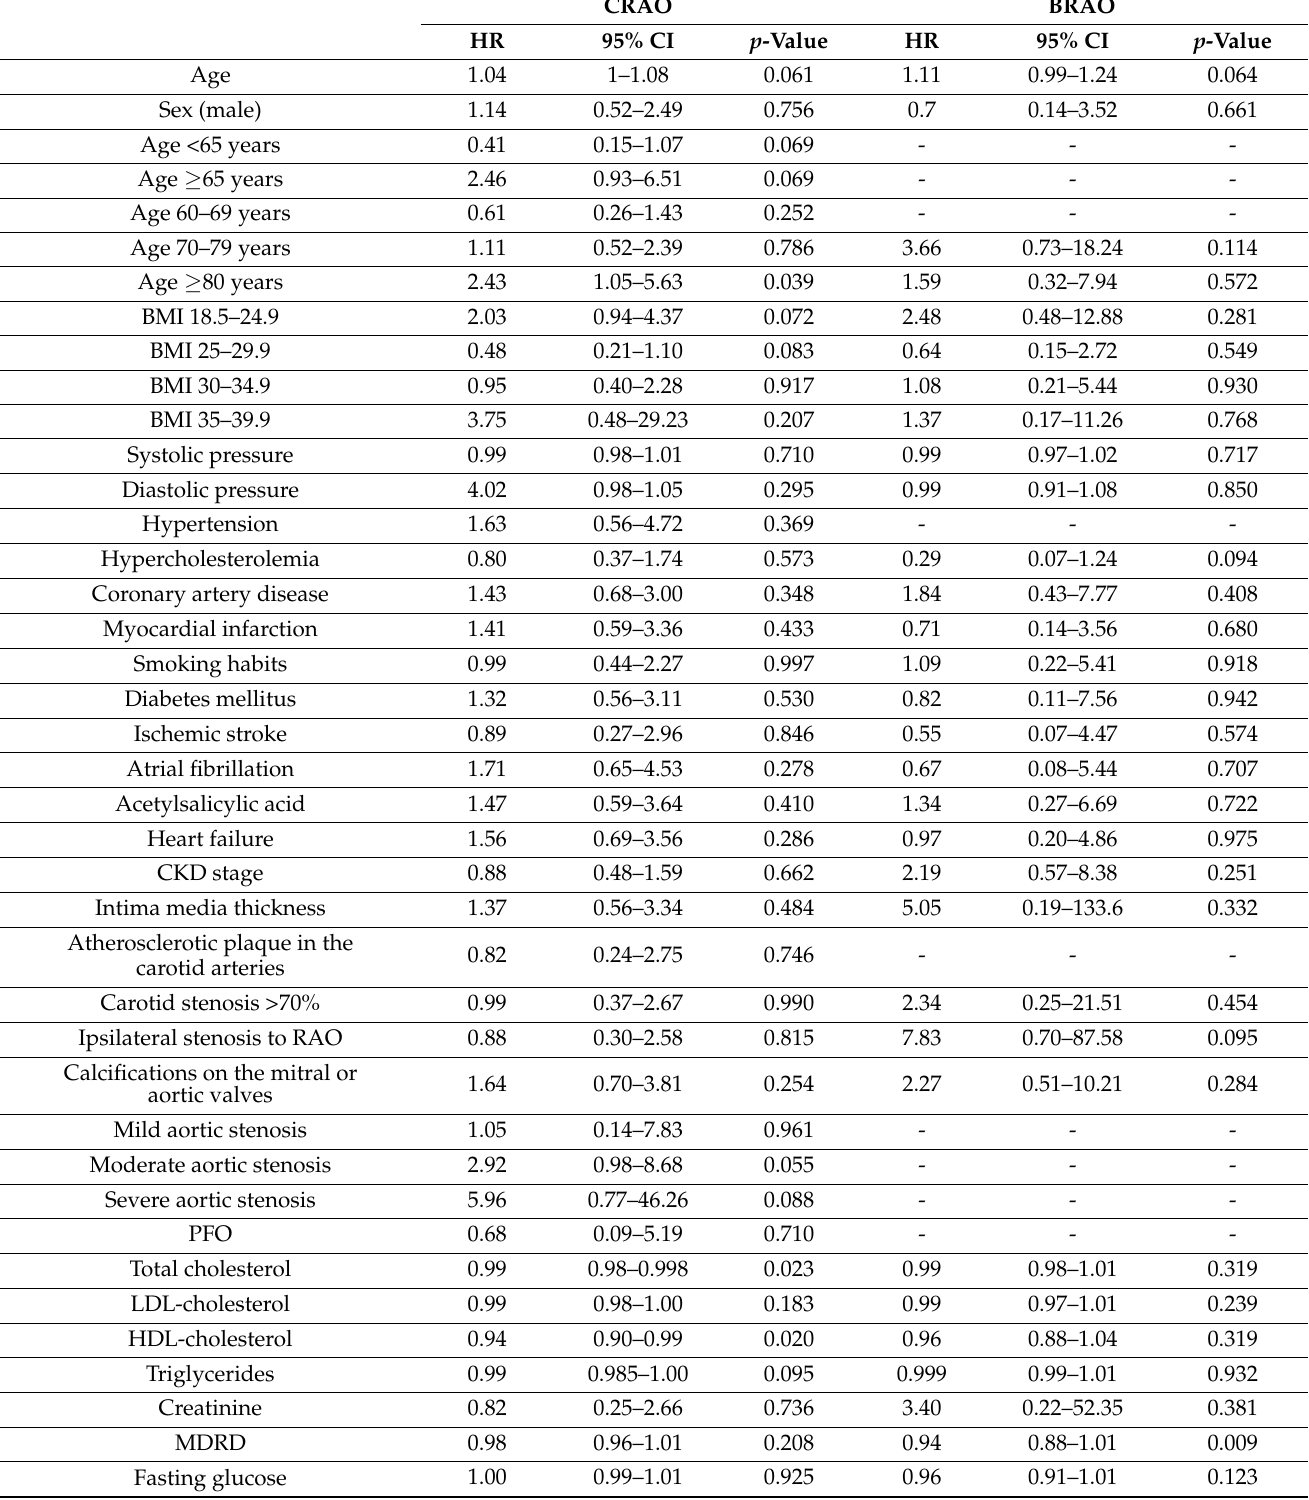
Table 3. Univariate Cox regression analyses for the composite endpoint for CRAO and